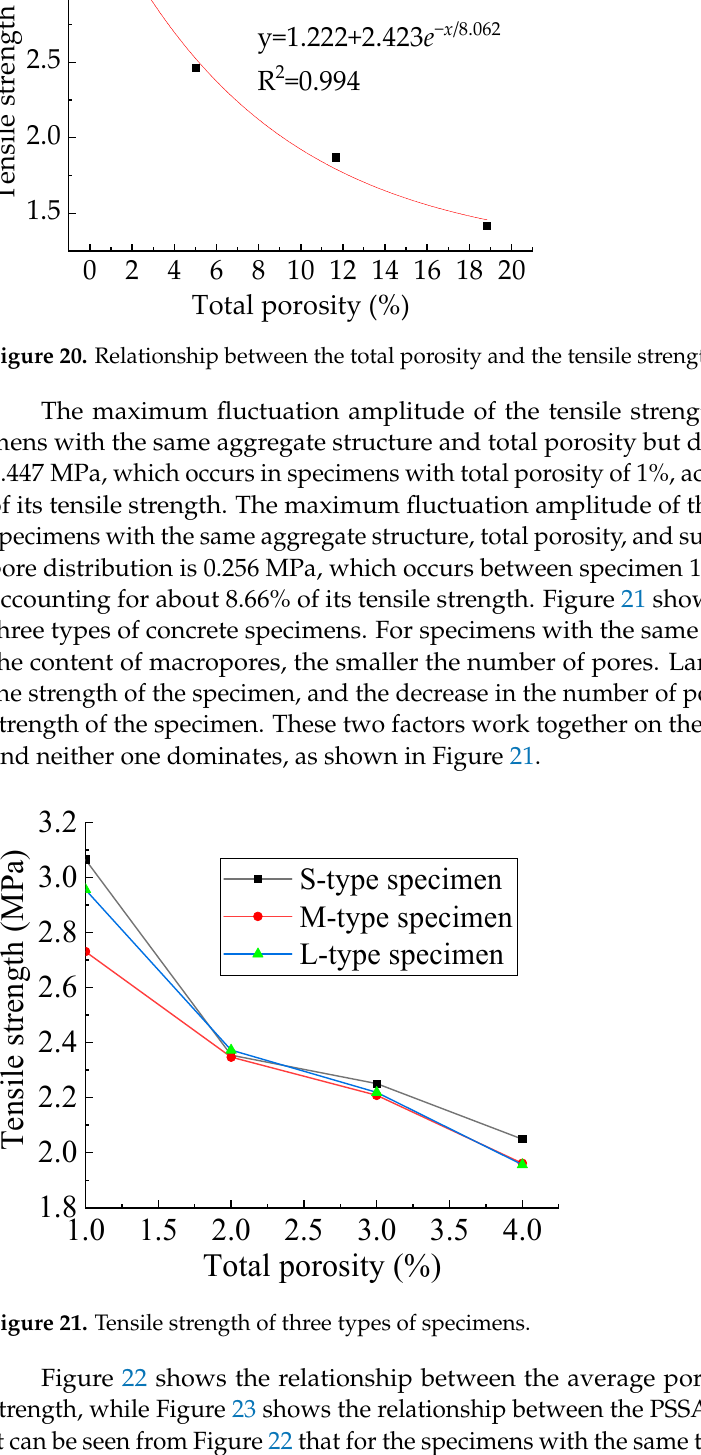
Figure 21. Tensile strength of three types of specimens. Figure 22 shows the relationship between the average pore radius and the tensile strength, while Figure 23 shows the relationship between the PSSA and the tensile strength. It can be seen from Figure 22 that for the specimens with the same total porosity, the average pore radius has little effect on the tensile strength of concrete, which is consistent with the research results of Du Xiuli